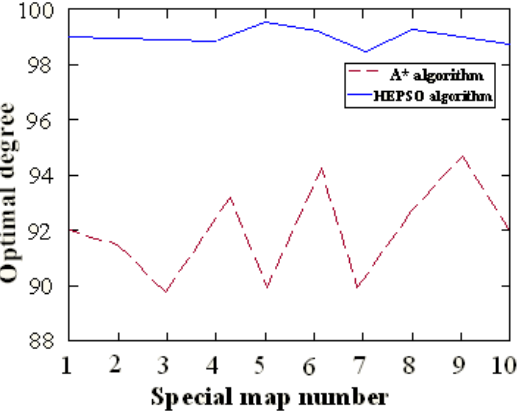
Figure 7. Comparison of optimal degrees on distinct maps of A* and HEPSO